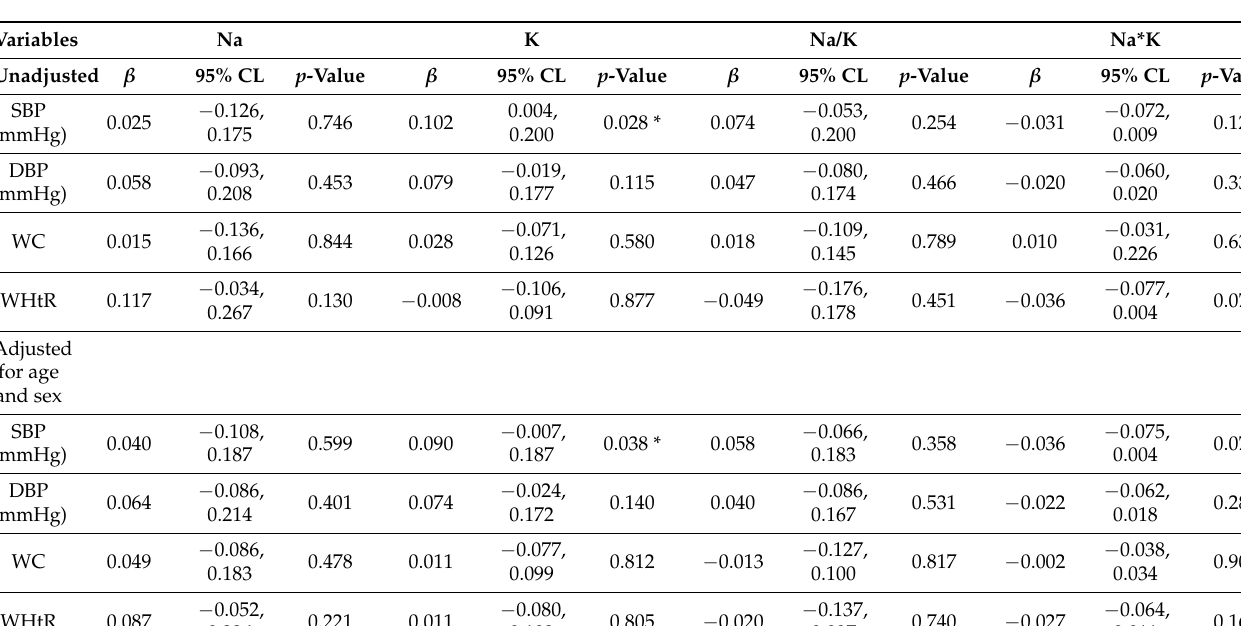
Table 5. Regression coefficients ( β ) and 95 % confidence intervals (CI) of the generalised linear